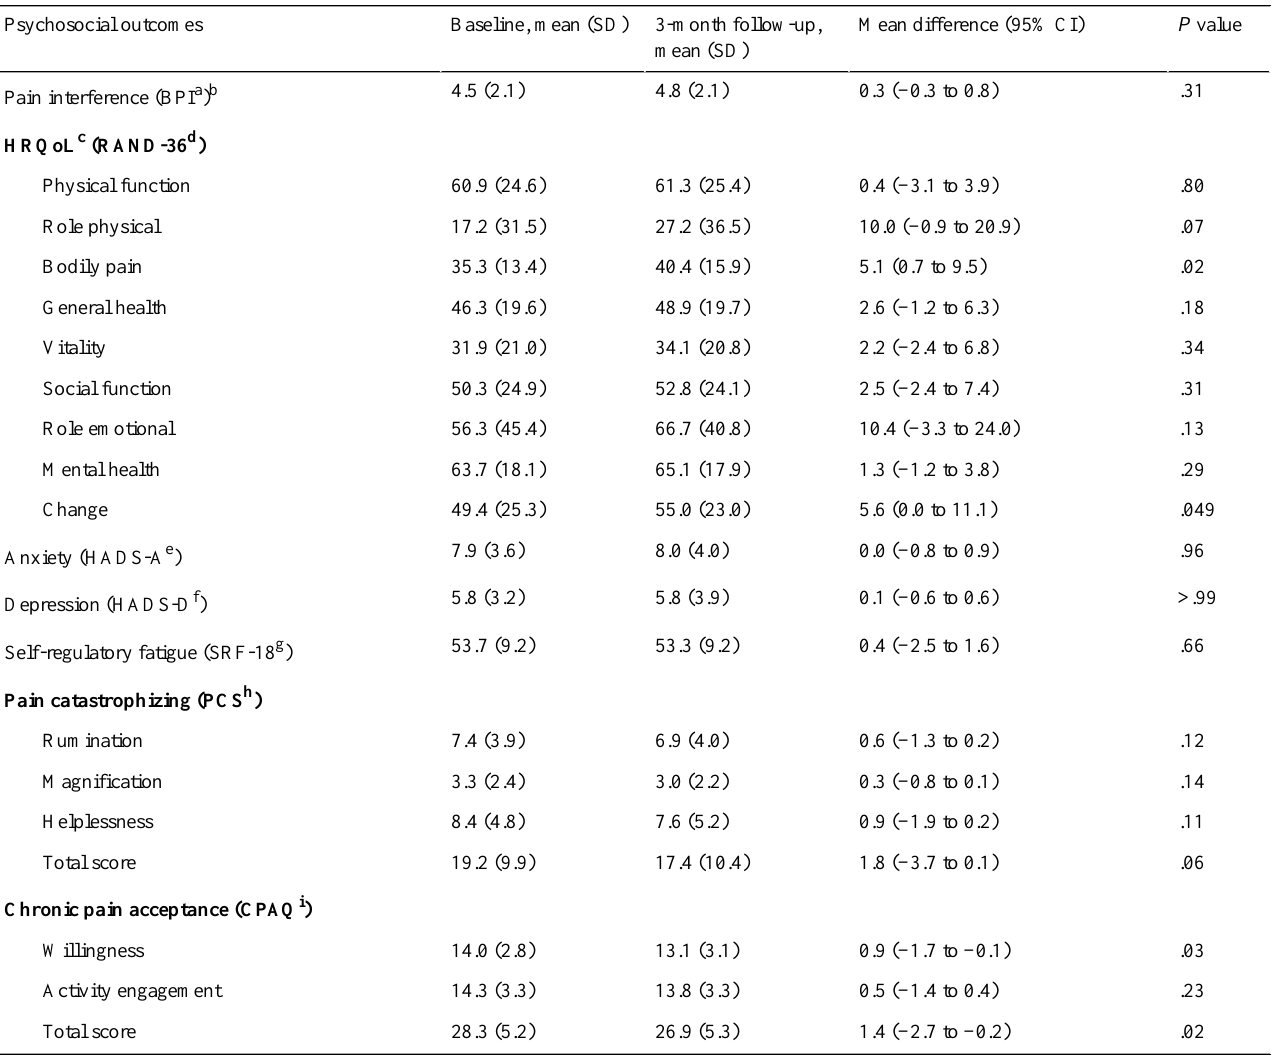
Table 2. Preliminary effects: pre-post intervention changes in psychosocial outcomes (n=45).